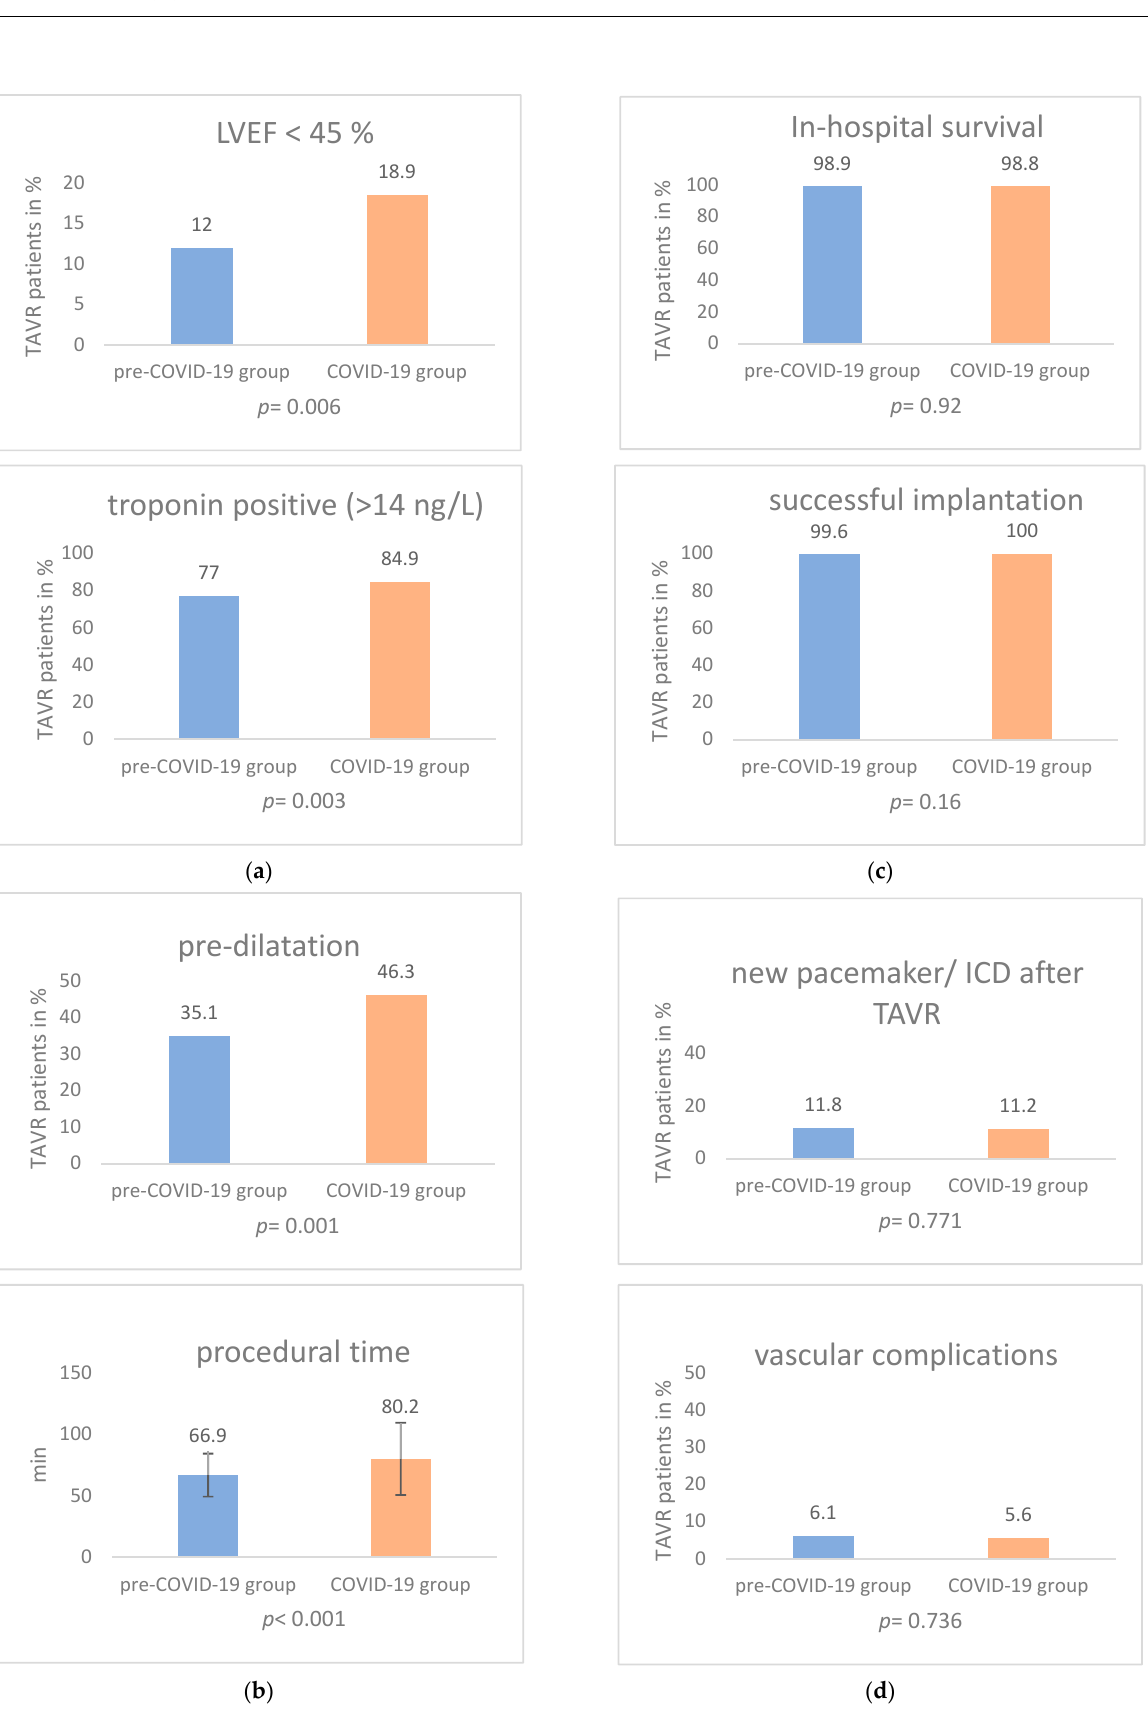
Figure 2. ( a ) Patient characteristics; ( b ) procedural characteristics; ( c ) efficacy and survival; ( d ) VARC- 2